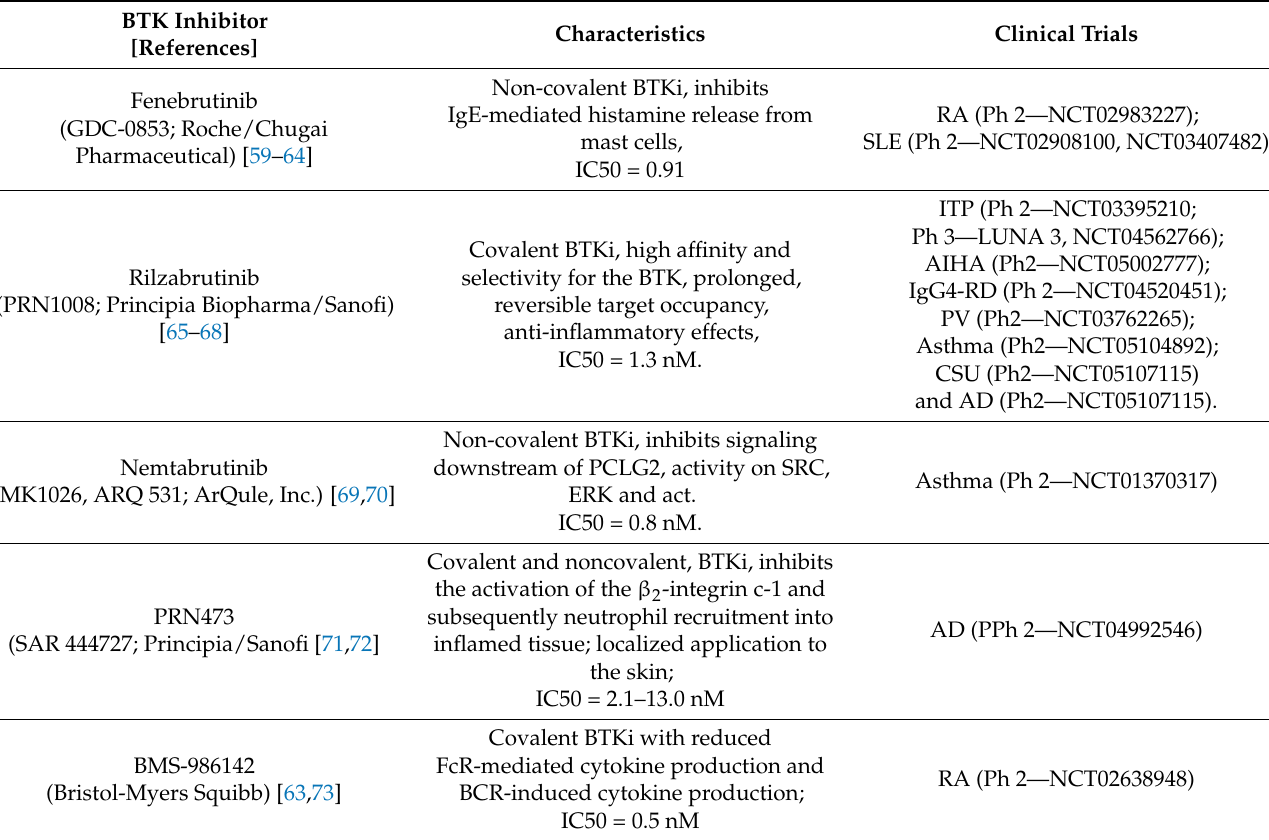
Table 2. Reversible Bruton’s kinase inhibitors studied in immune